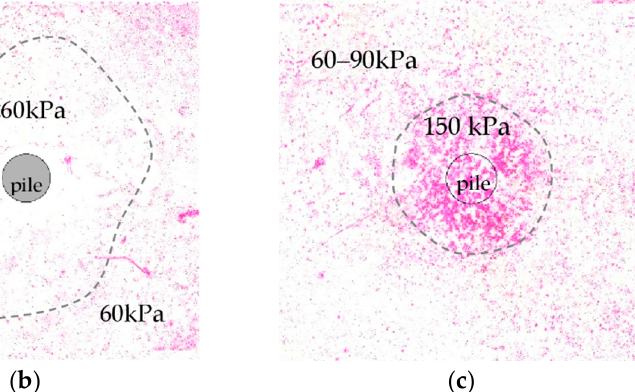
Figure 19. Pressure in the soil obtained from the test P6.R.CFS: ( a ) At half of the pile length level (20 cm below the ground). ( b ) At the pile base level (40 cm below the ground). ( c ) 10 cm below the pile base (50 cm below the ground).